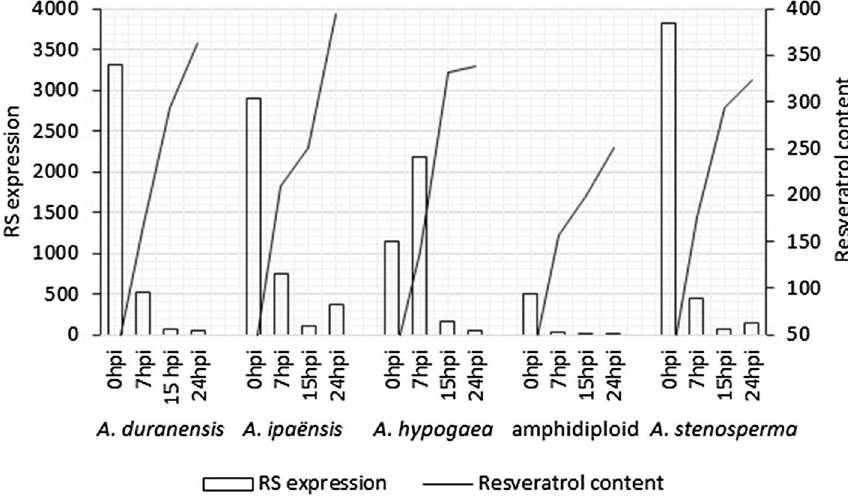
Figure 2. Resveratrol concentration and the relative expression of RS in each of the four collection times in relation to the control. Overall, the data suggest that there is an inverse relationship between resveratrol concentrations and RS